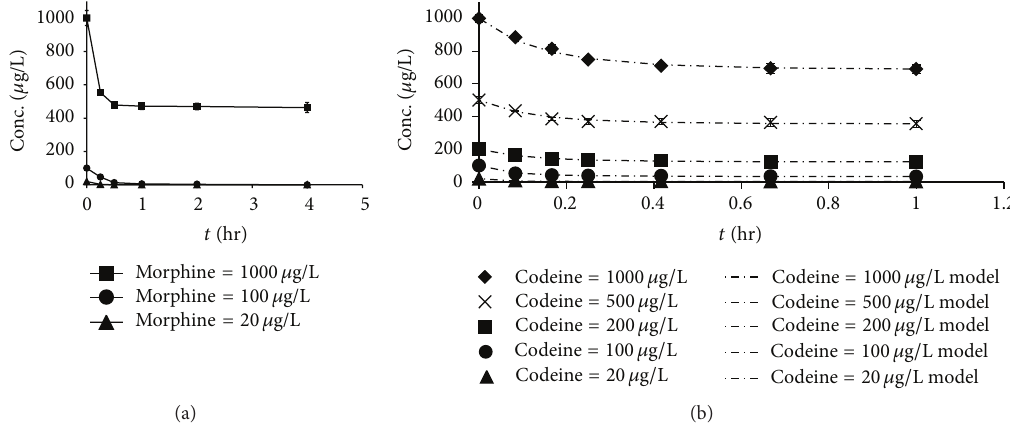
Figure 4: Effect of initial compound concentration on the oxidation of controlled substances by MnO 2 : (a) morphine (with 100 𝜇 g/L MnO 2 ) and (b) codeine (with 8 mg/L MnO 2 ) (pH = 7, ionic strength = 10mM) (the second-order kinetic model developed by Zhang et al. [11] was fitted to describe the codeine